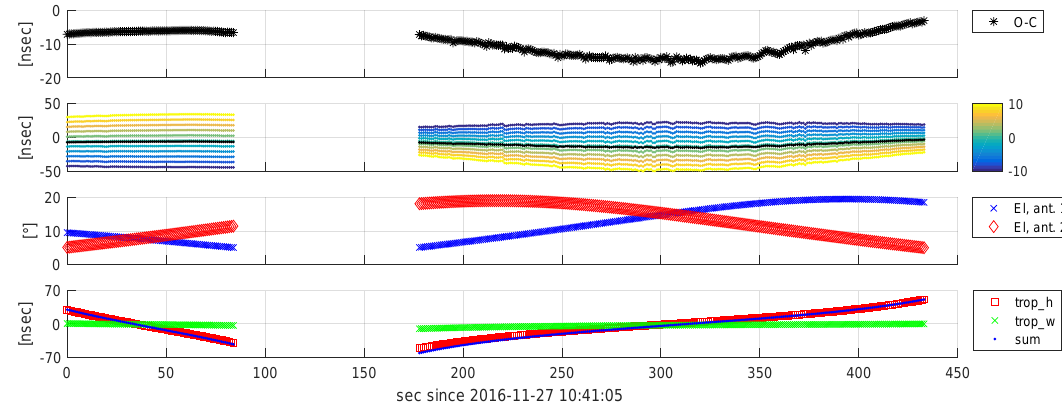
Figure 12. Residual delays (o-c) and modeled delay corrections of Scans 168 and 169 of Experiment a332. From top to bottom: (1) observed delays (ionosphere free linear combination) minus computed delays (o-c), (2) o-c residuals with the APOD position shifted by values between − 10 and + 10 m in the along-track direction (shift amounts are color-coded, no shift indicated by black line), (3) observation elevations at Stations 1 (blue crosses) and 2 (red diamonds), and (4) applied corrections for the hydrostatic (red squares) and wet parts (green crosses) of the atmosphere and the sum of both (blue